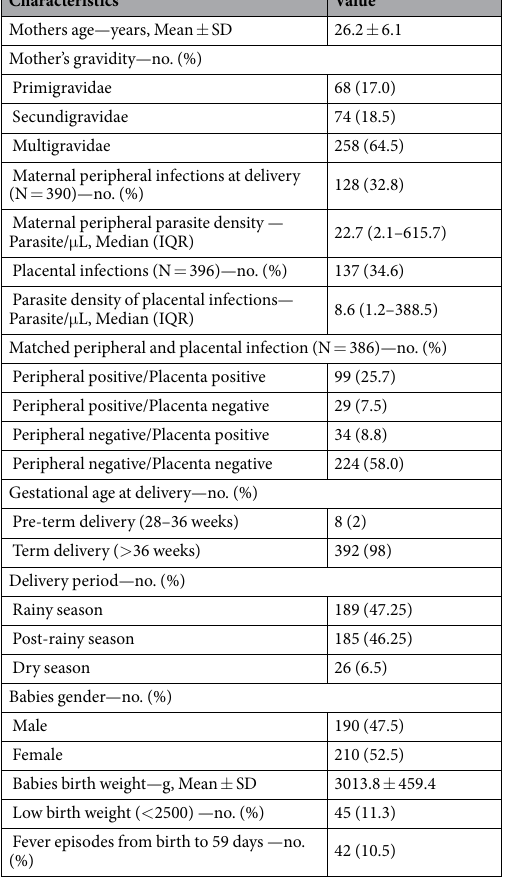
Table 1. Characteristics of the mother-child pairs * . * The characteristics are described for the 400 mother-child pairs, unless indicated otherwise. SD, Standard Deviation; IQR, Interquartile Range; g,